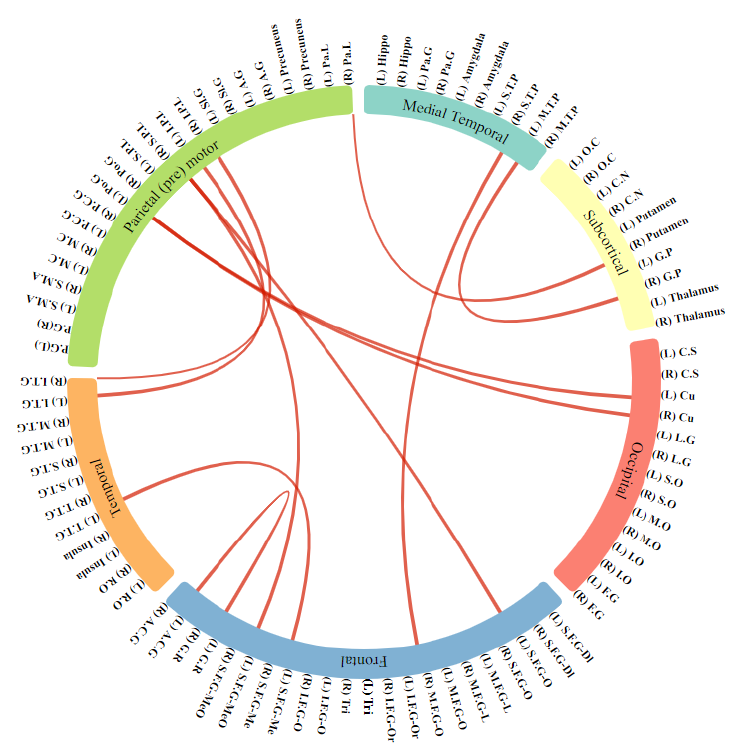
Figure 5. Connectogram for the six regions of the